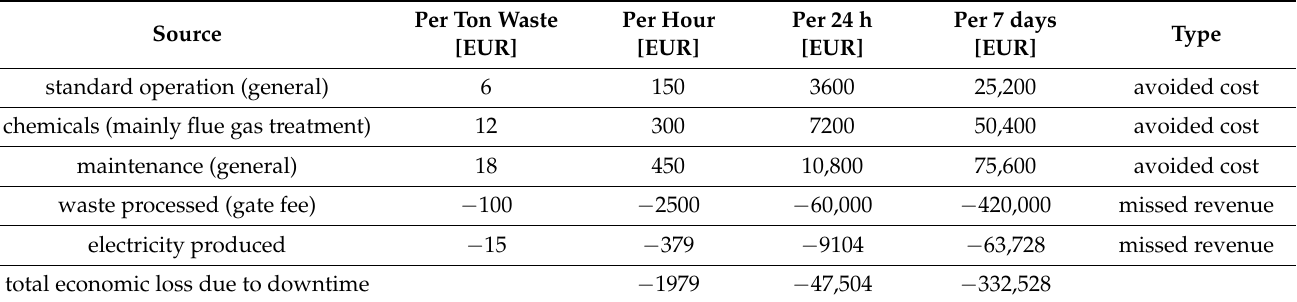
Table 2. Estimation of overall economic loss due to unplanned downtime of a single WtE